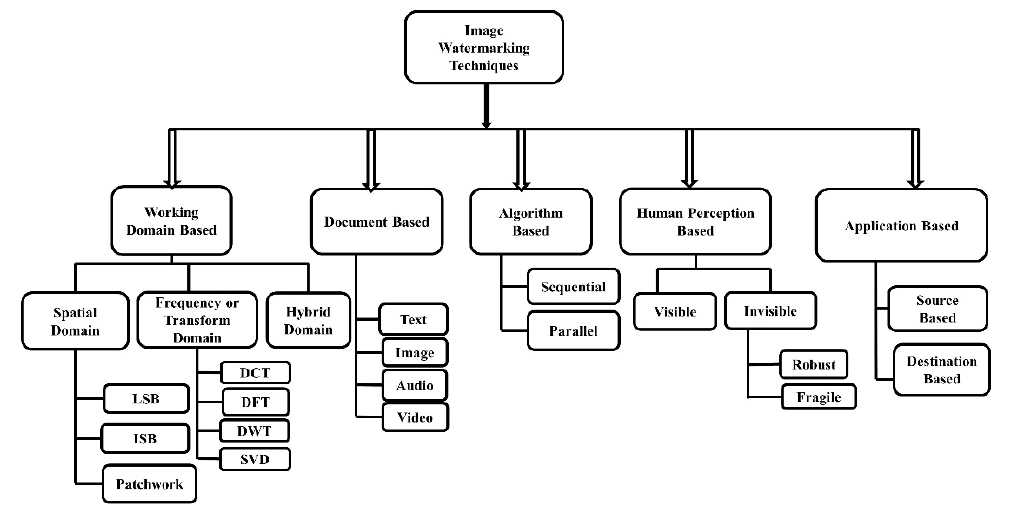
Figure 7. Classification of image watermarking techniques.